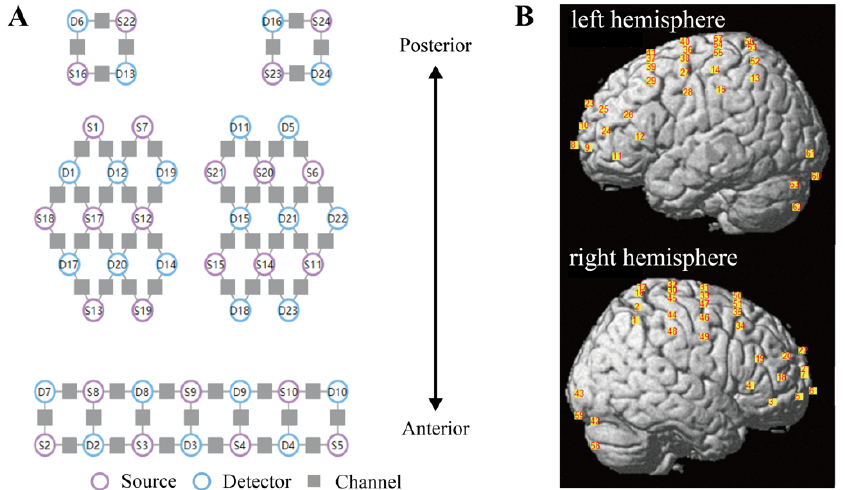
Figure 1. Configuration of fNIRS optodes. ( A ) The layout of sources (purple circles), detectors (blue circles), and channels (gray squares). A total of 24 sources and 24 detectors were placed with a source–detector distance of 3 cm, creating 63 channels. ( B ) Spatial registration of channels. Positions of channels on the brain are shown in the left (top figure) and right (bottom figure) hemispheres. fNIRS functional near-infrared spectroscopy.